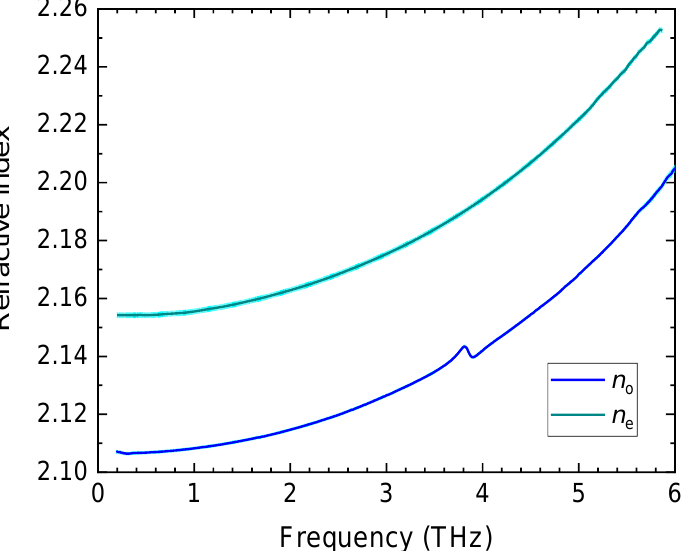
Figure 2. The ordinary ( n o ) and extraordinary ( n e ) refractive indices of quartz crystal. The uncertain- ties are shown by light blue shading.